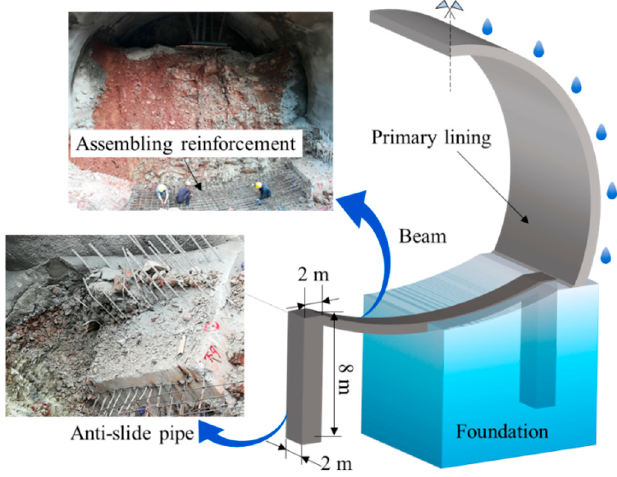
Figure 8. Anti − slide